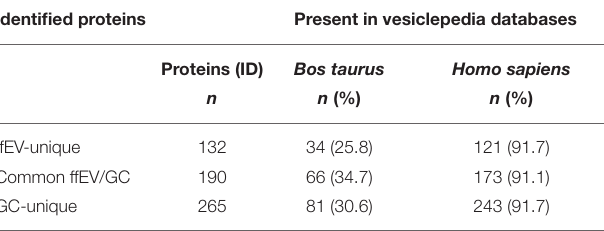
TABLE 2 | Presence of follicular fluid extracellular vesicle (ffEV) and granulosa cell (GC) proteins in Vesiclepedia databases. Identified proteins Present in vesiclepedia